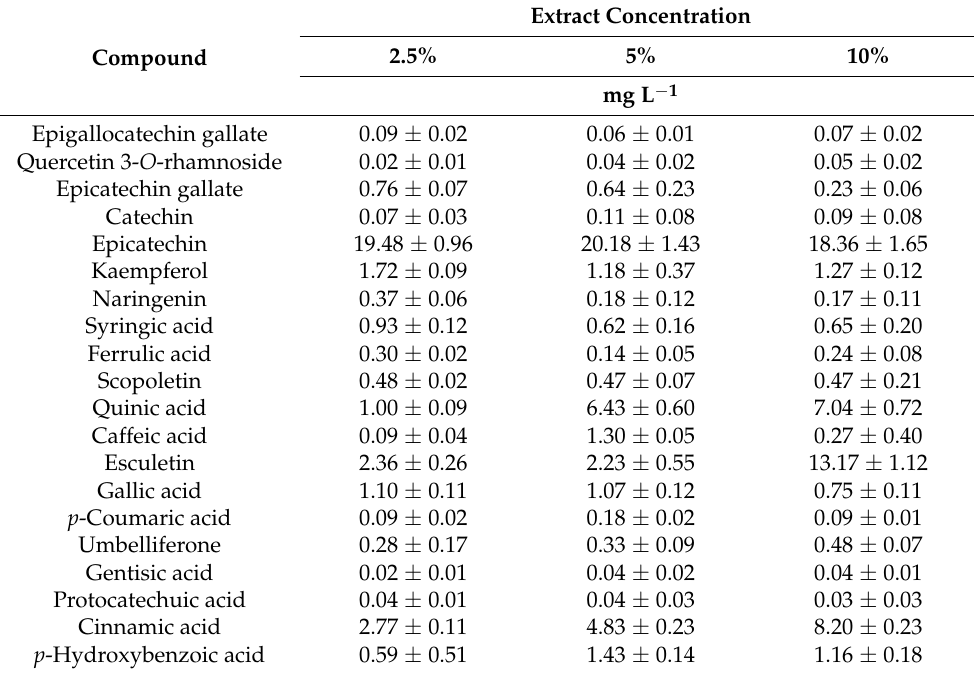
Table 3. Phytochemical composition of wormwood herbs ( A. absinthium L.) aqueous extracts of different